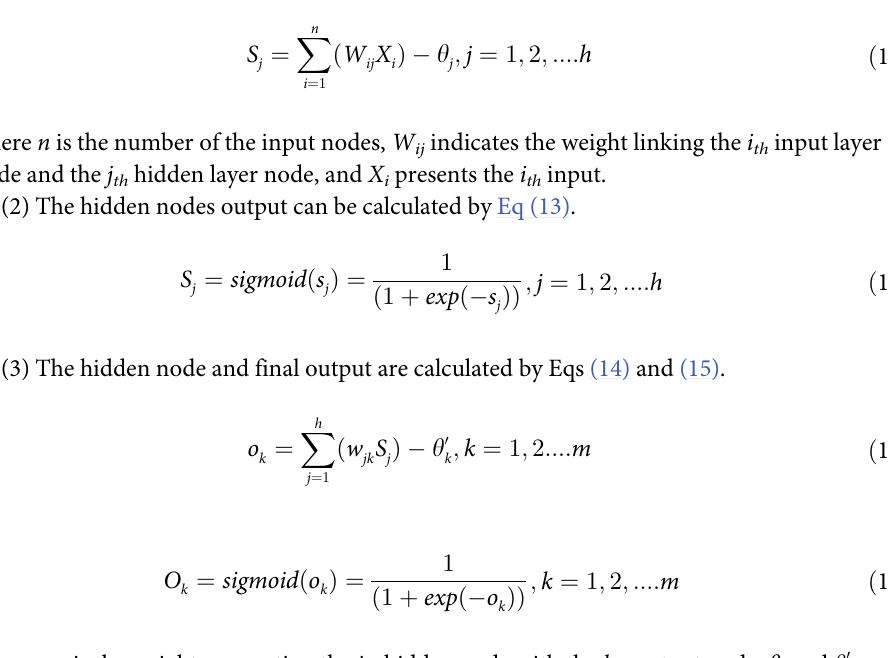
function. The basic structure of multi-layer perception consists of three layers: the first input layer, the middle hidden layer, and the last output layer. The input elements and weights